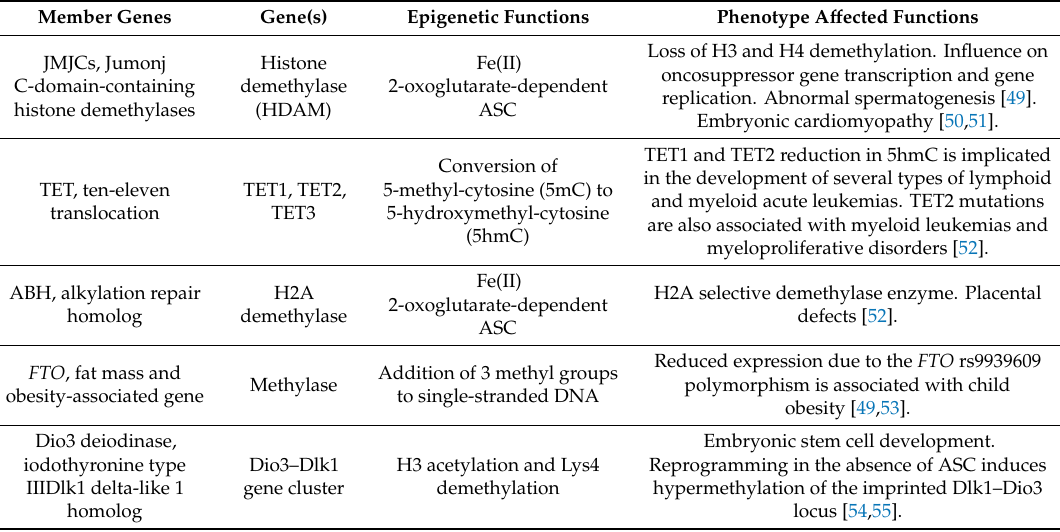
Table 2. Main ASC-dependent genes and enzymes involved in epigenetic modifications [49–55].